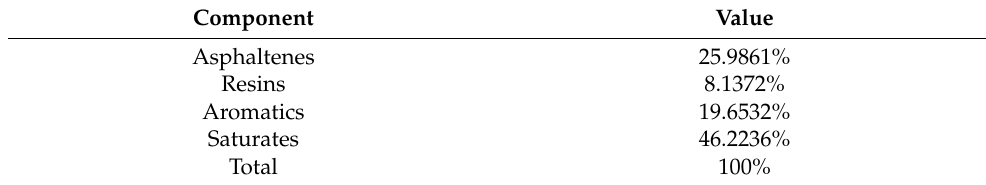
Table 6. Results of SARA analysis of crude